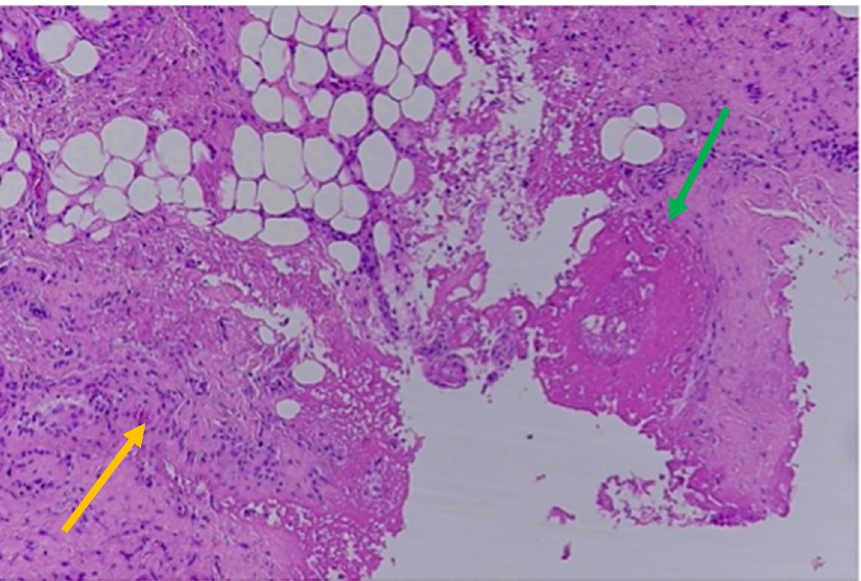
Figure 3. Histological findings of 5-day-old bruises: new capillary blood vessels (green arrow); gran- ulation tissue; infiltration of macrophages and lymphocytes (yellow arrow; Hematoxylin & Eosin).